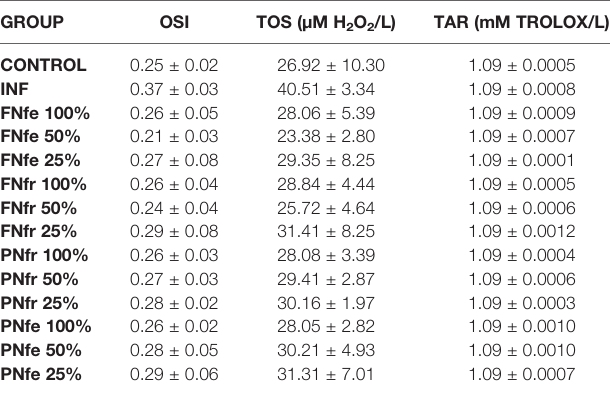
TABLE 2 | In vivo antioxidant global tests